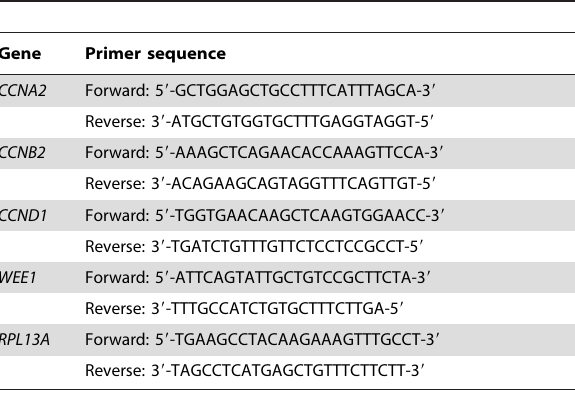
Table 1. A list of the genes and primers used in the Real Time RT-PCR